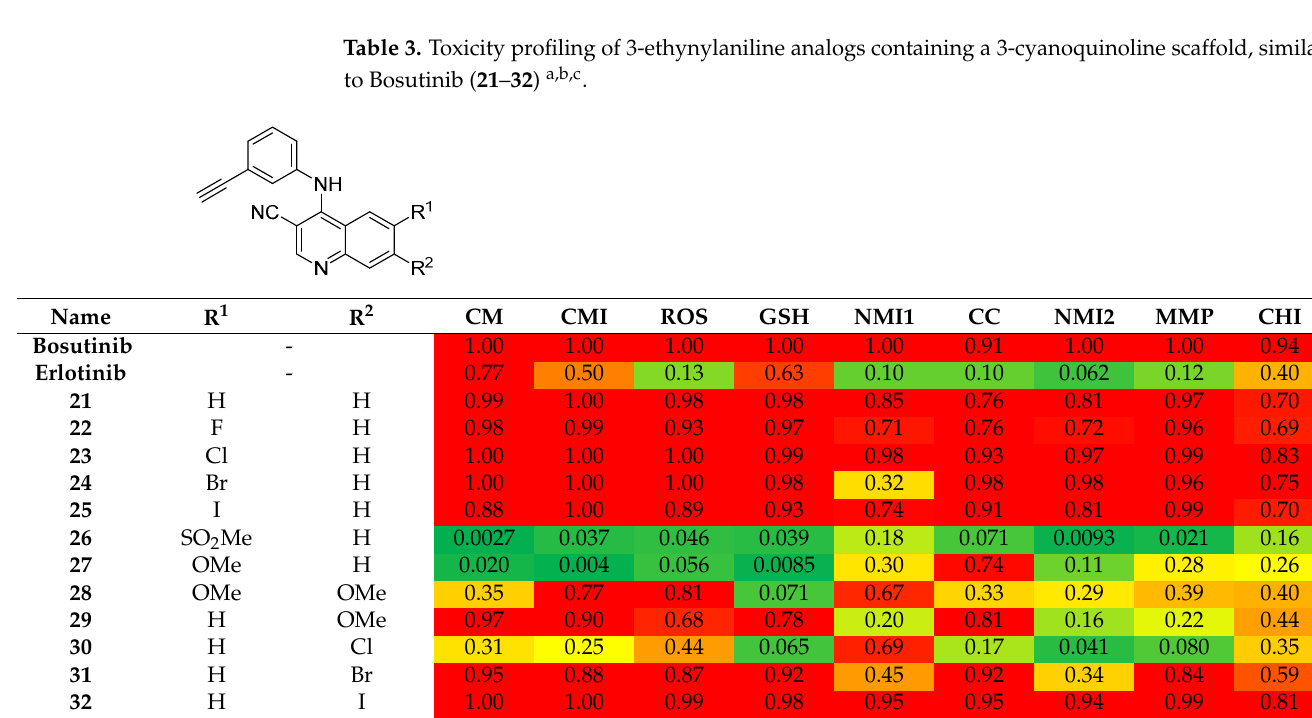
Table 3. Toxicity profiling of 3-ethynylaniline analogs containing a 3-cyanoquinoline scaffold, similar to Bosutinib ( 21 – 32 ) a,b,c .